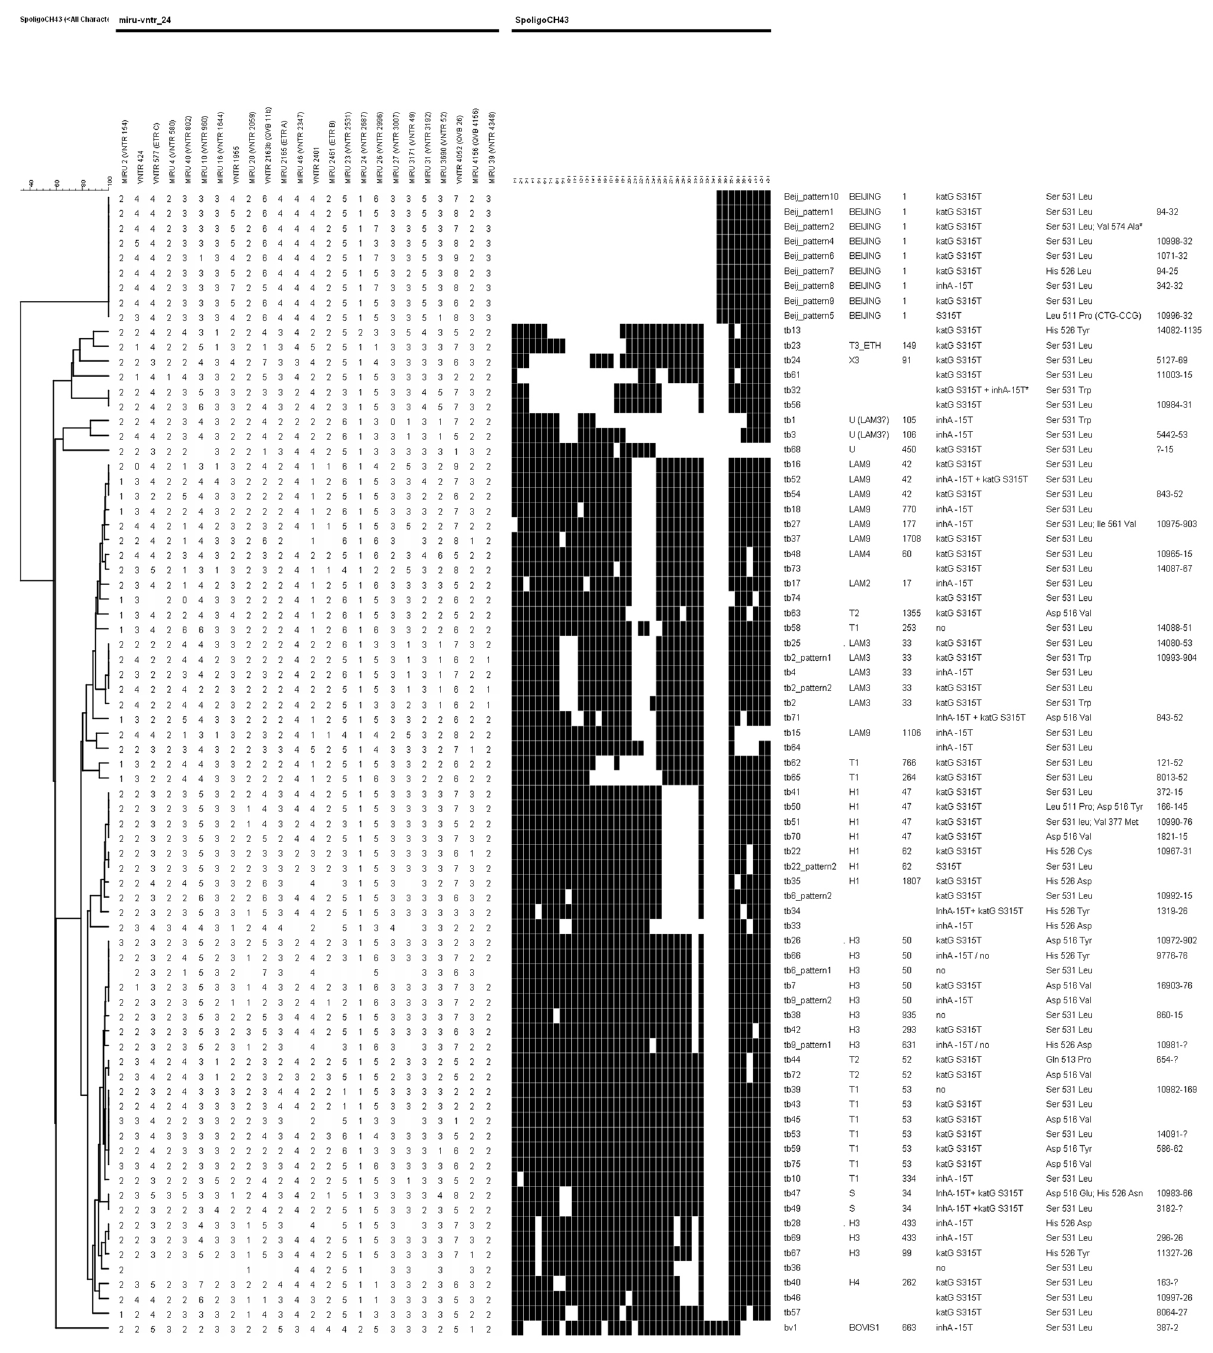
Figure 3. Spoligotyping based dendrogram of the 77 MDR M. tuberculosis cluster patterns from Spain. SIT, Spoligo-International Type. Mycobacterial interspersed repetitive-unit variable-number tandem-repeat (MIRU- VNTR) pattern of each cluster, mutations associated to resistance to isoniazid and rifampicine and the cluster name in TESSy are